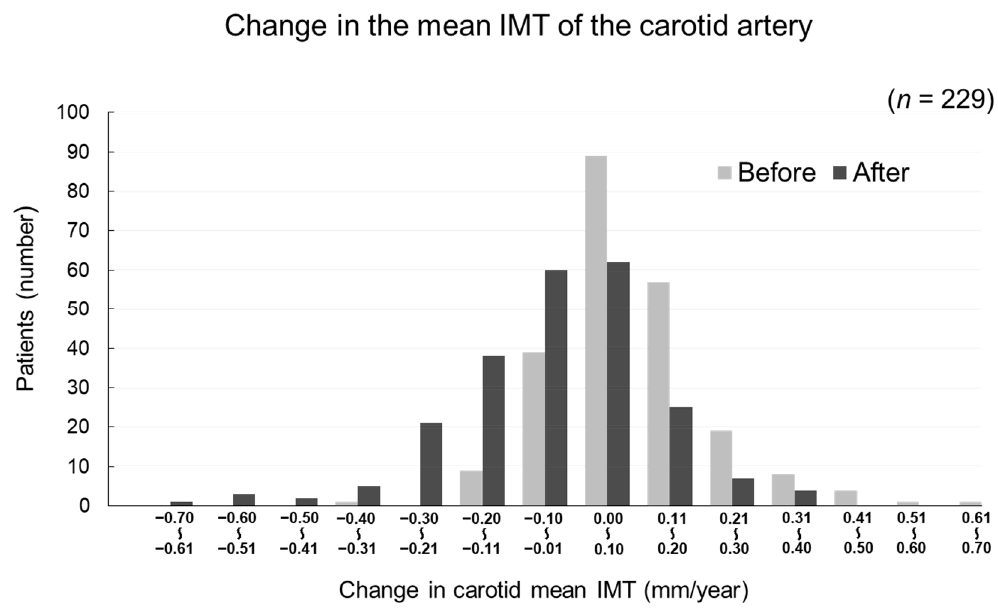
Figure 4. Distribution of participants according to the change in carotid mean IMT during the 12 months before and after the administration of evolocumab.